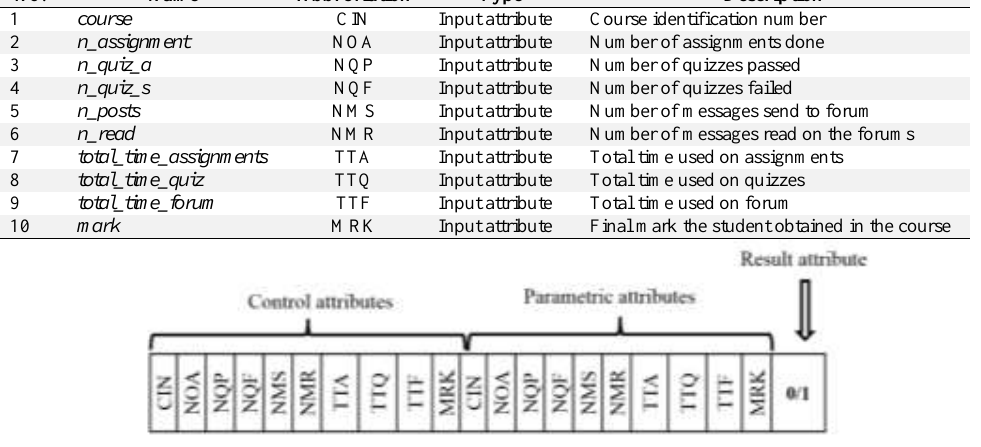
Figure 6. Labels of particle attributes.